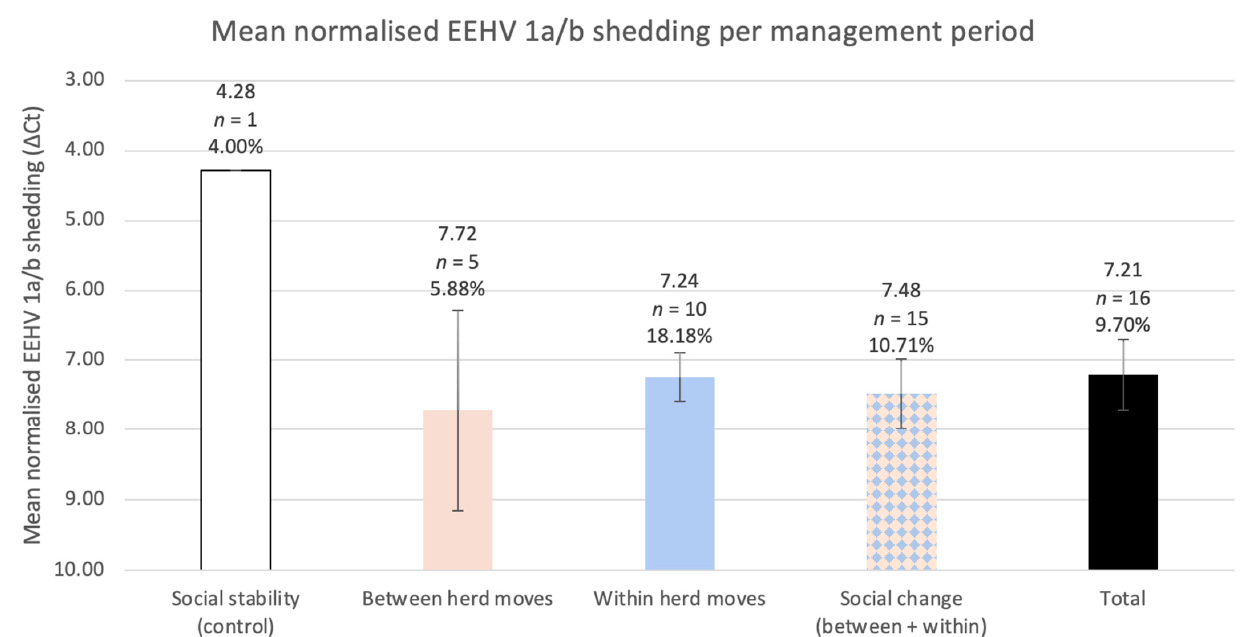
Figure 4. The study herd’s mean normalised EEHV 1a/b DNA load for each management period, with corresponding error bars (95% confidence intervals). The percentage of positive samples is listed below each sample size and was calculated identically to those in Figure 3. Low Cts represent higher viral DNA, therefore, the y-axis is inverted to visualise the relationship between Δ Ct (normalised shedding) and the relative viral DNA. GEEs informed by normalised shedding revealed significantly less viral DNA per sample within all social change periods compared to the singular positive control sample (social change p = 1.1 × 10 − 10 ; between herd moves p = 0.0074; within herd moves p < 2 × 10 − 16 ).